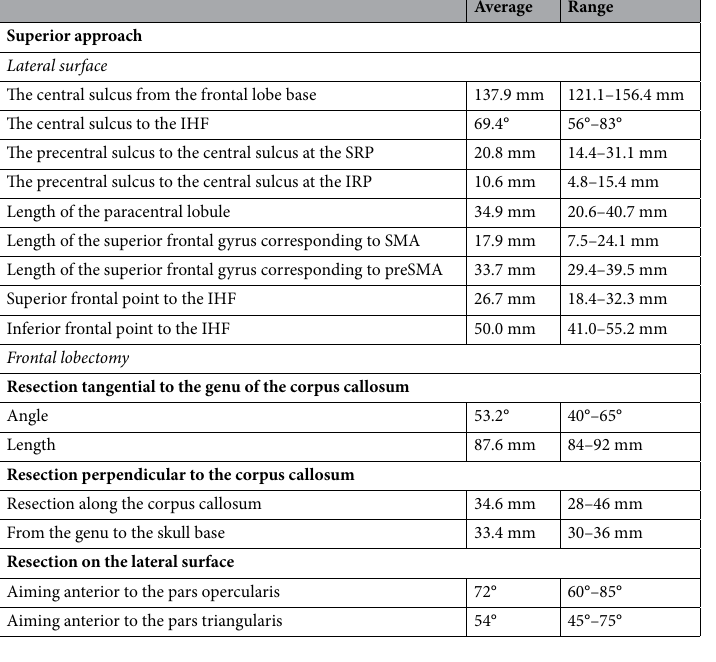
Table 1. Measurements related to the superior approach.